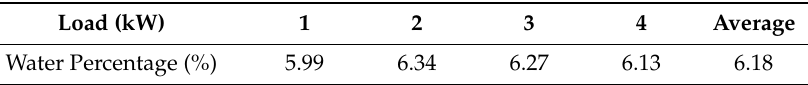
Table 2. Water percentage of SD.